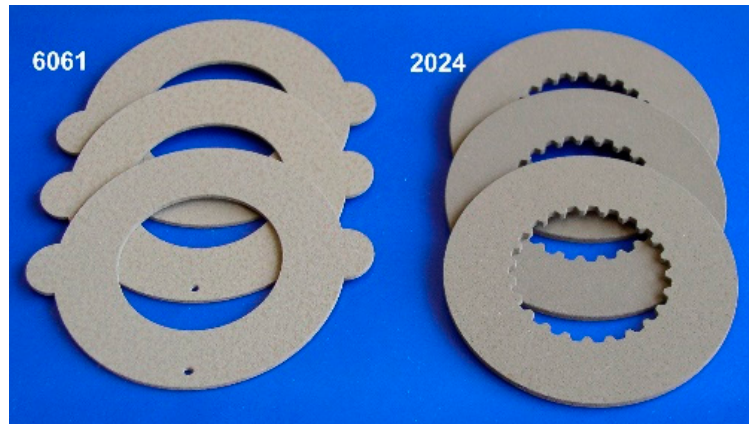
Figure 2. Appearance of the clutch disks with a plasma electrolytic oxidation (PEO) coating including basalt mineral powder.